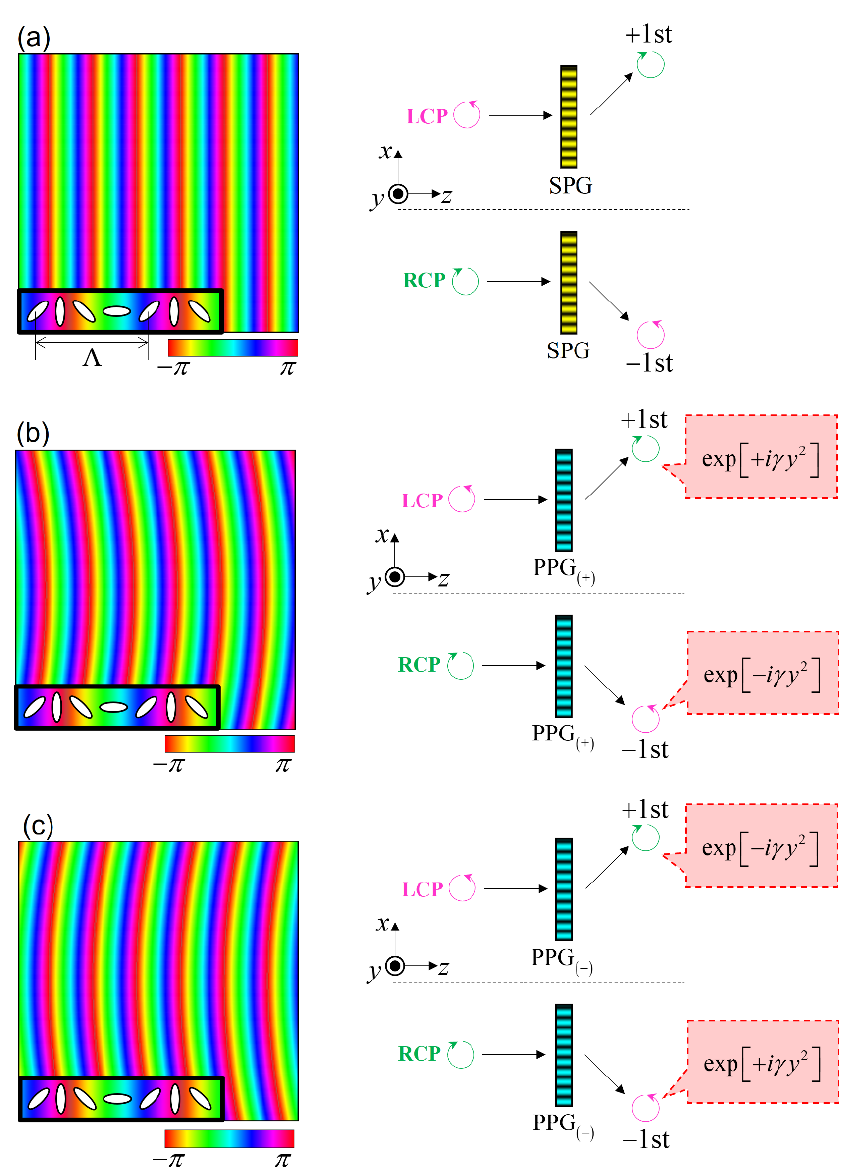
Figure 2. Structure (left) and function (right) of ( a ) SPG, ( b ) PPG (+) , and ( c ) PPG ( − ) .